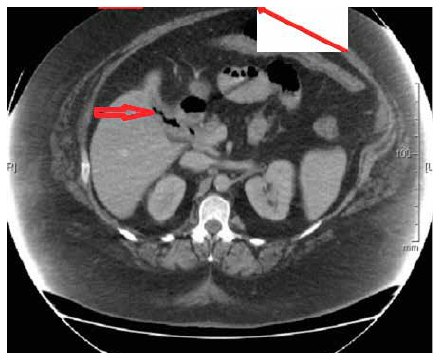
Figure 2: Abdominal ultrasound depicting a large stone in the gallbladder (red arrow).